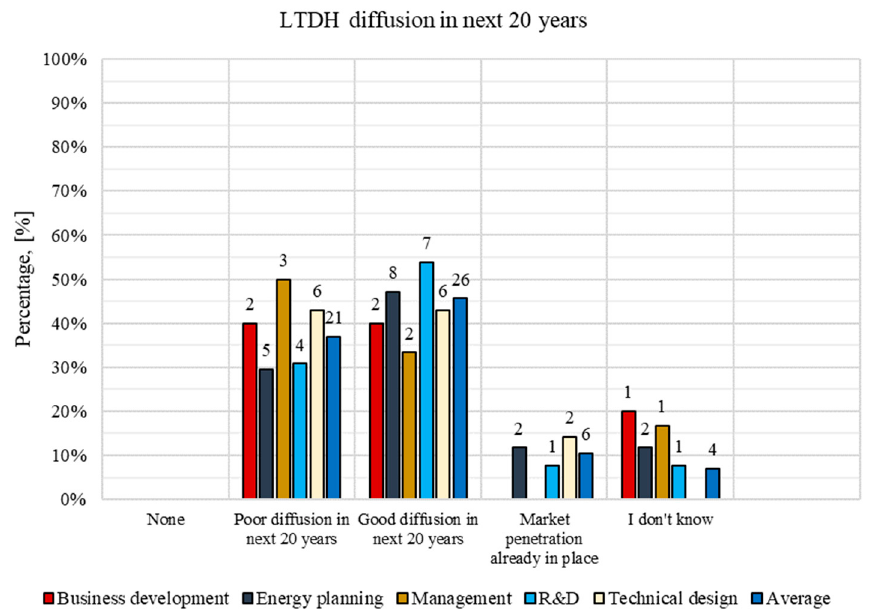
Figure 35 . LTDH concept diffusion over the next 20 years as a function of the employment role.